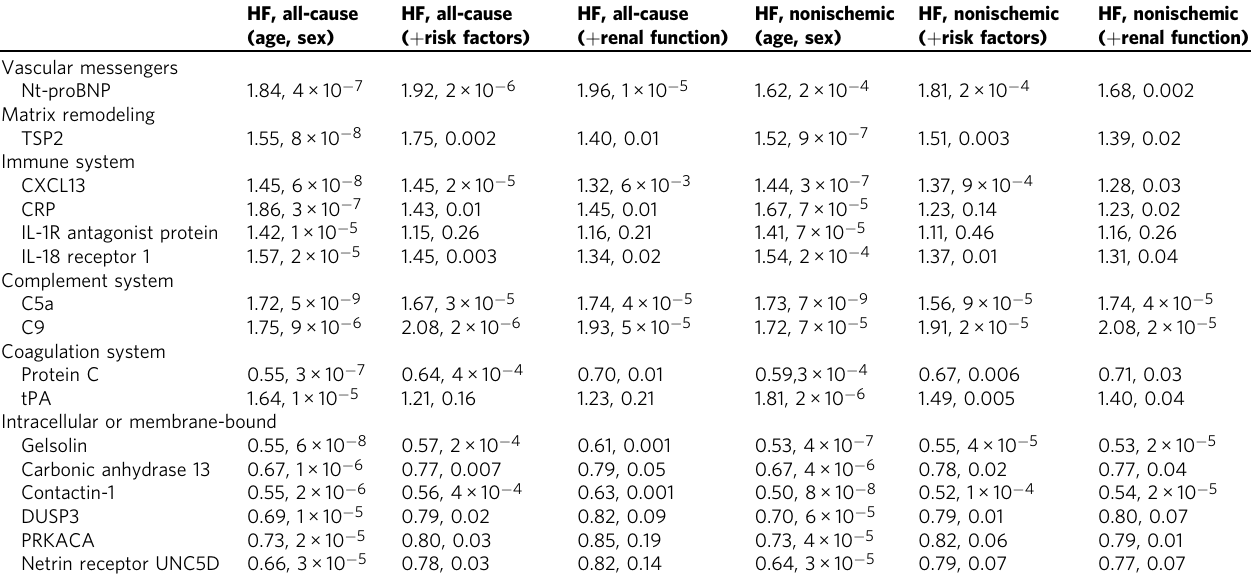
HF, all-cause HF, all-cause (age, sex) ( + risk factors)